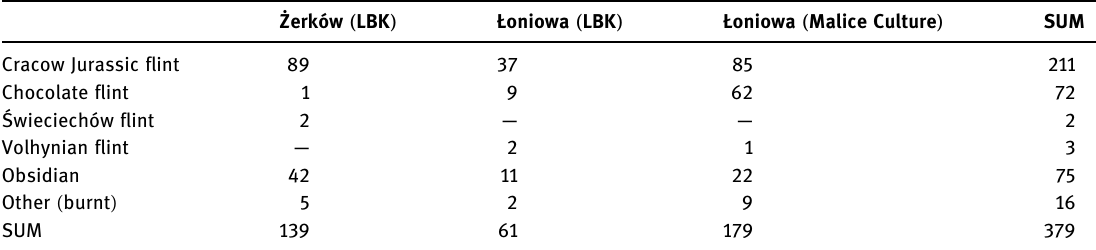
Table 1: Ż erków, com. Gnojnik, site 1 and Ł oniowa, com. D ę bno, site 18. Structure of general raw materials of LBK and Malice stone